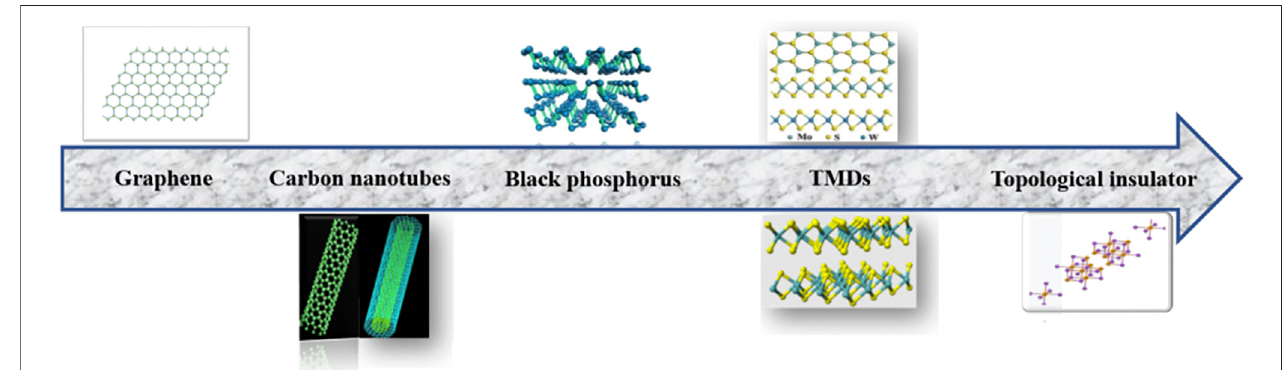
FIGURE 1 | Low-dimensional material crystal structure.